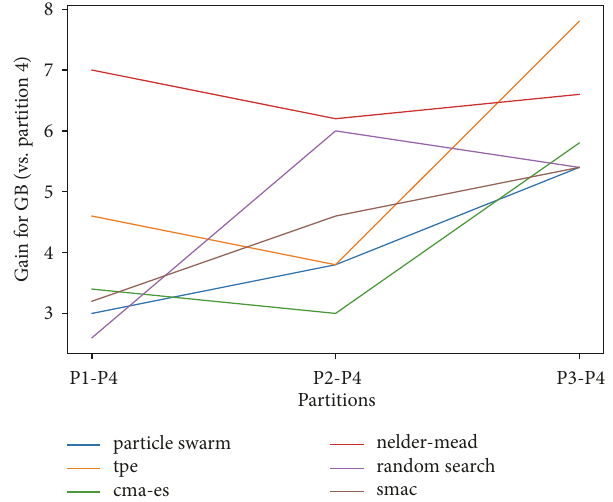
Figure 5: Average of gain for each smaller partition with respect to the whole dataset in GB.